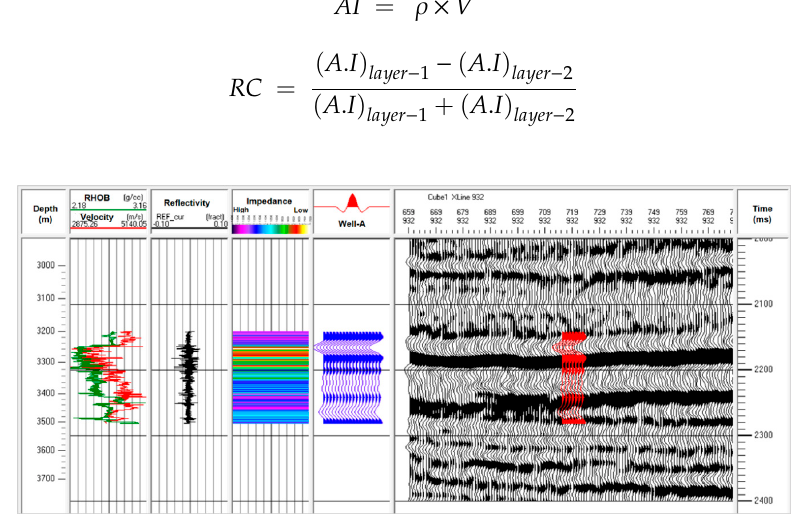
Figure 10. Synthetic seismogram for Well-C, showing (left to right): TVD (true vertical depth) in meters, sonic transit time (µs/ft) and bulk density from logs (g/cm 3 ), RC (reflection coefficient), synthetic seismogram, traces from a portion of seismic Xline 932, and TWT (two-way time in ms).